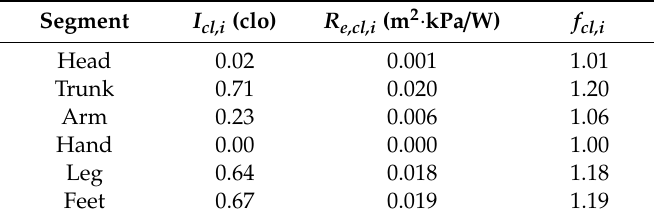
Table 2. Clothing insulation and vapor resistance.